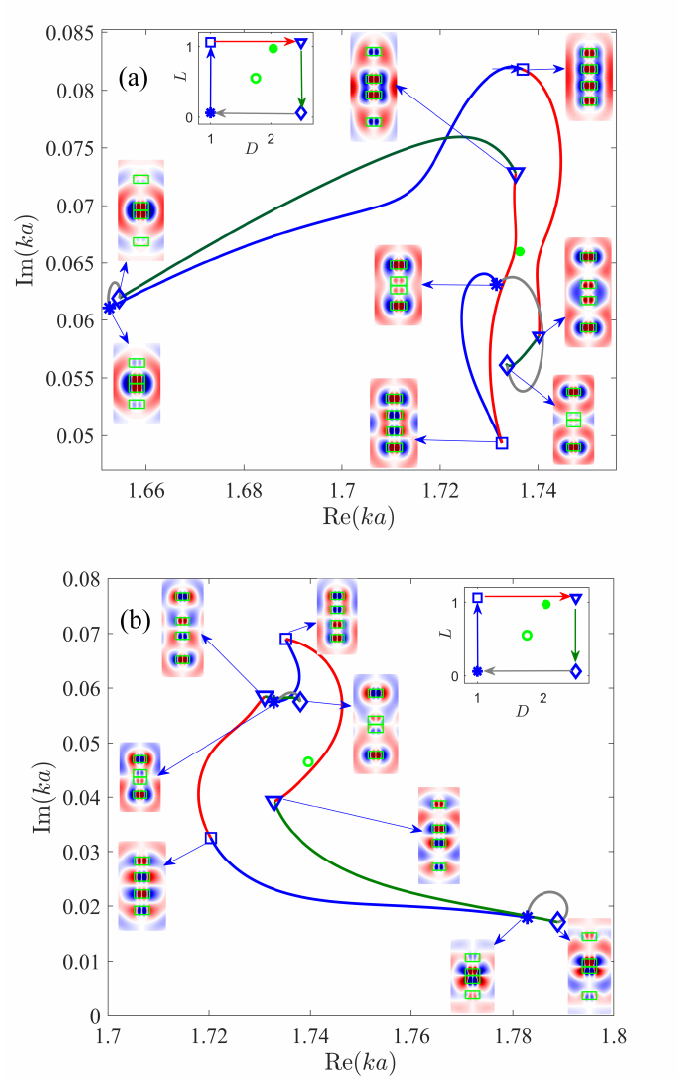
Figure 5. Encircling of the symmetric EP ( a ) and anti-symmetric EP ( b ) listed in Table 1 by the number 1 and marked by closed and open circles. The insets show the component E φ of